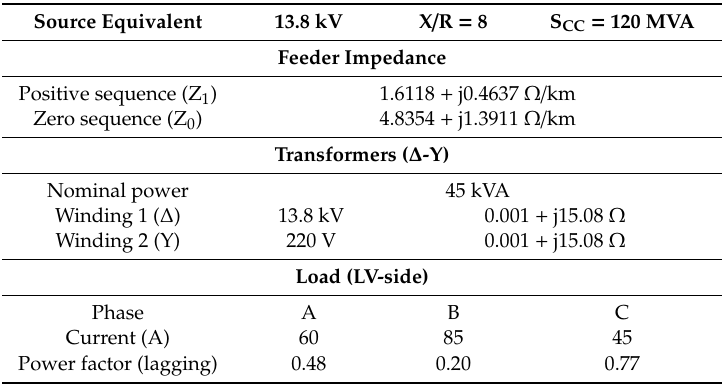
Figure 3. Three-phase feeder diagram with Y-connected loads and an opening at phase A. Table 1. Parameters of the supply voltage and the loads connected at the LV-side.